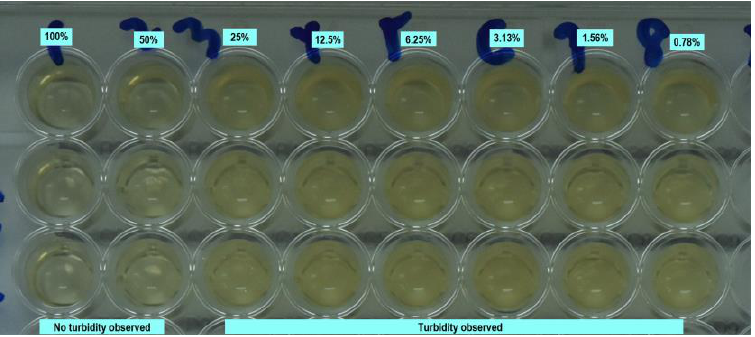
Figure 2. Observation of Enterococcus faecalis growth in a 96-well plate at different concentrations of P-EE fermented for 3 months.